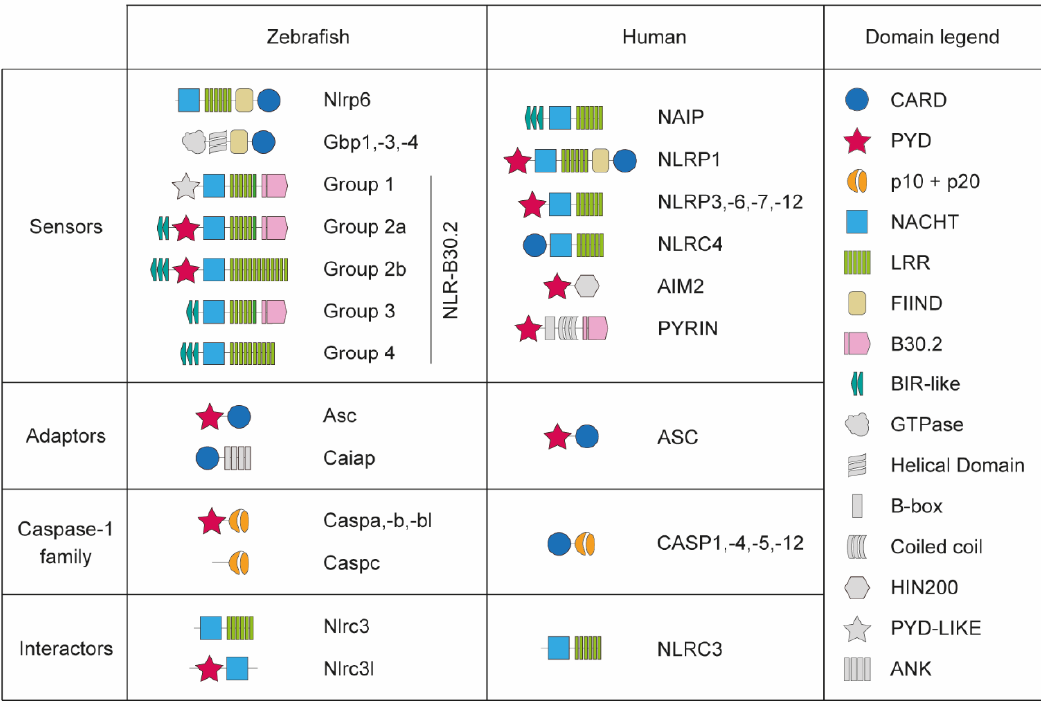
Figure 1. Schematic representation of protein domains in the components involved in inflammasome function in zebrafish.